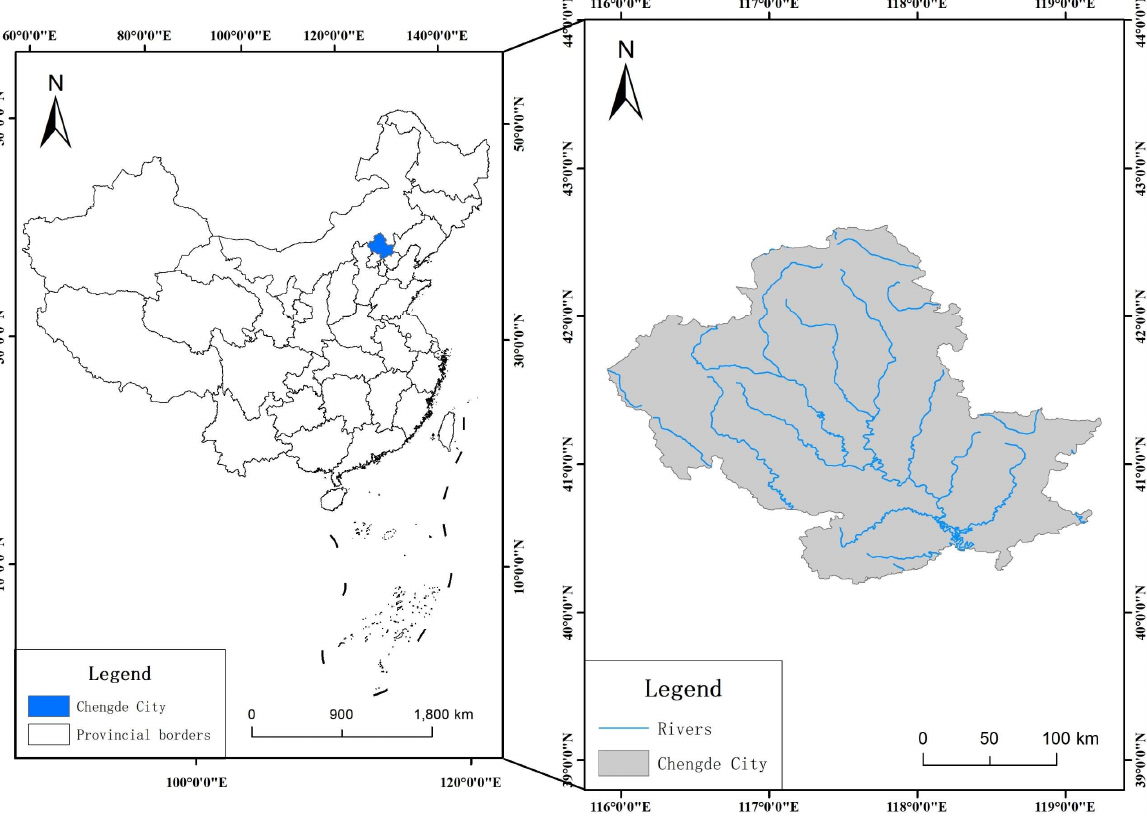
Figure 2. The study